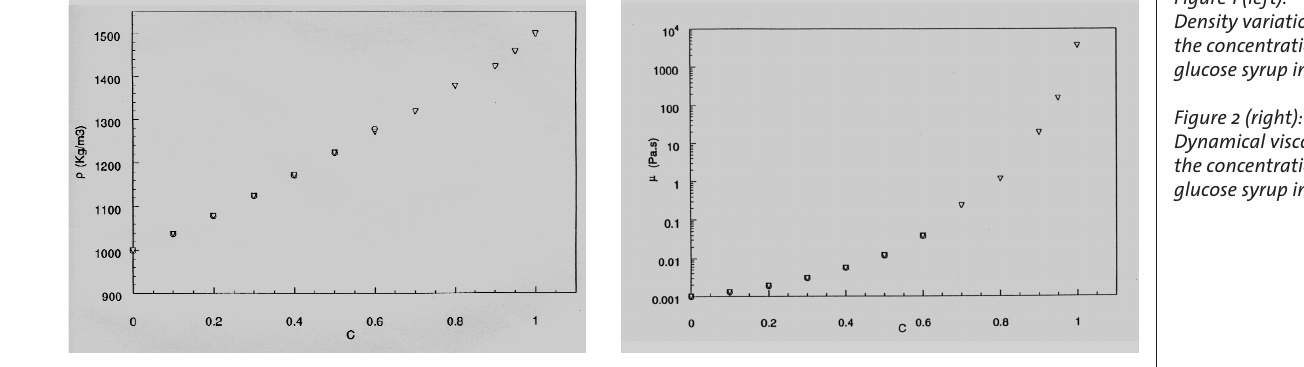
Figure 1 (left): Density variation against the concentration of the glucose syrup in the water. Figure 2 (right): Dynamical viscosity against the concentration of the glucose syrup in the